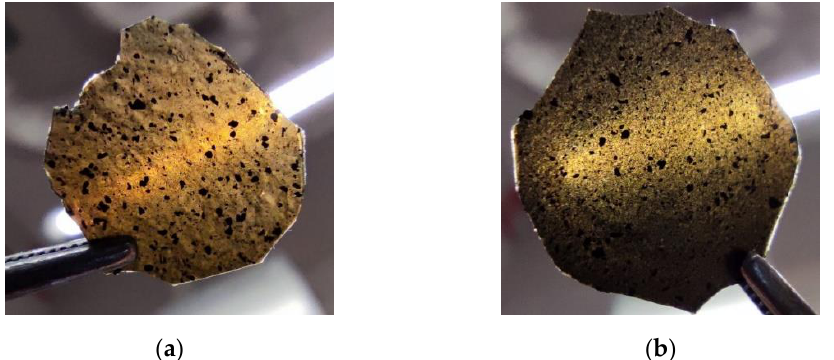
Figure 4. Created hybrid layers of Ecoflex ® :SWCN (10:0.03) without ( a ) and with ( b ) the addition of oleic acid.